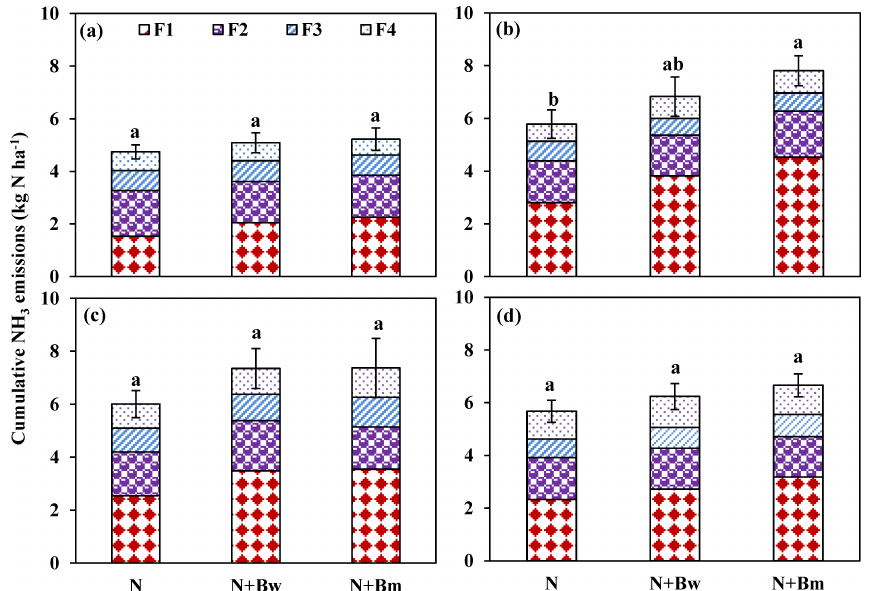
Figure 4. Cumulative ammonia (NH 3 ) emissions from the Acrisol (a) , Anthrosol (b) , Cambisol (c) and Phaeozem (d) during the four nitrogen fertilization events F : every N fertilization event. The bars indicate the standard deviation of the mean (kg Nha − 1 ± SD, n = 3) of each treatment for the sum of the four N fertilization events. See Fig. 1 for treatment codes. Different letters above the bars indicate significant differences among the different treatments for each soil, at p< 0 .